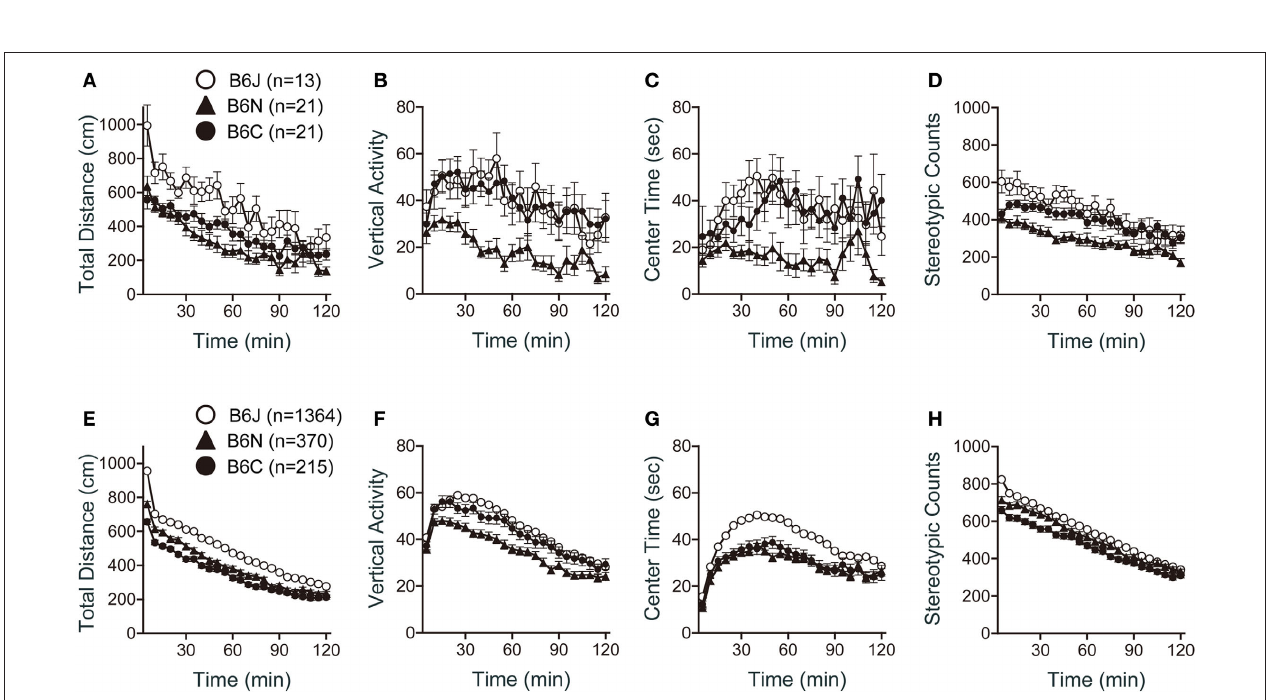
Figure 2 | Sensorimotor function tests of C57BL/6 substrains. (A,B) Regular scale analysis. (C,D) Large-scale analysis. (A,C) Hot plate test. C57BL/6J showed the shortest latencies in the large-scale analysis. (B,D) Rotarod test. C57BL/6J mice showed the longest latencies to fall. * p < 0.0001. Error bars indicate